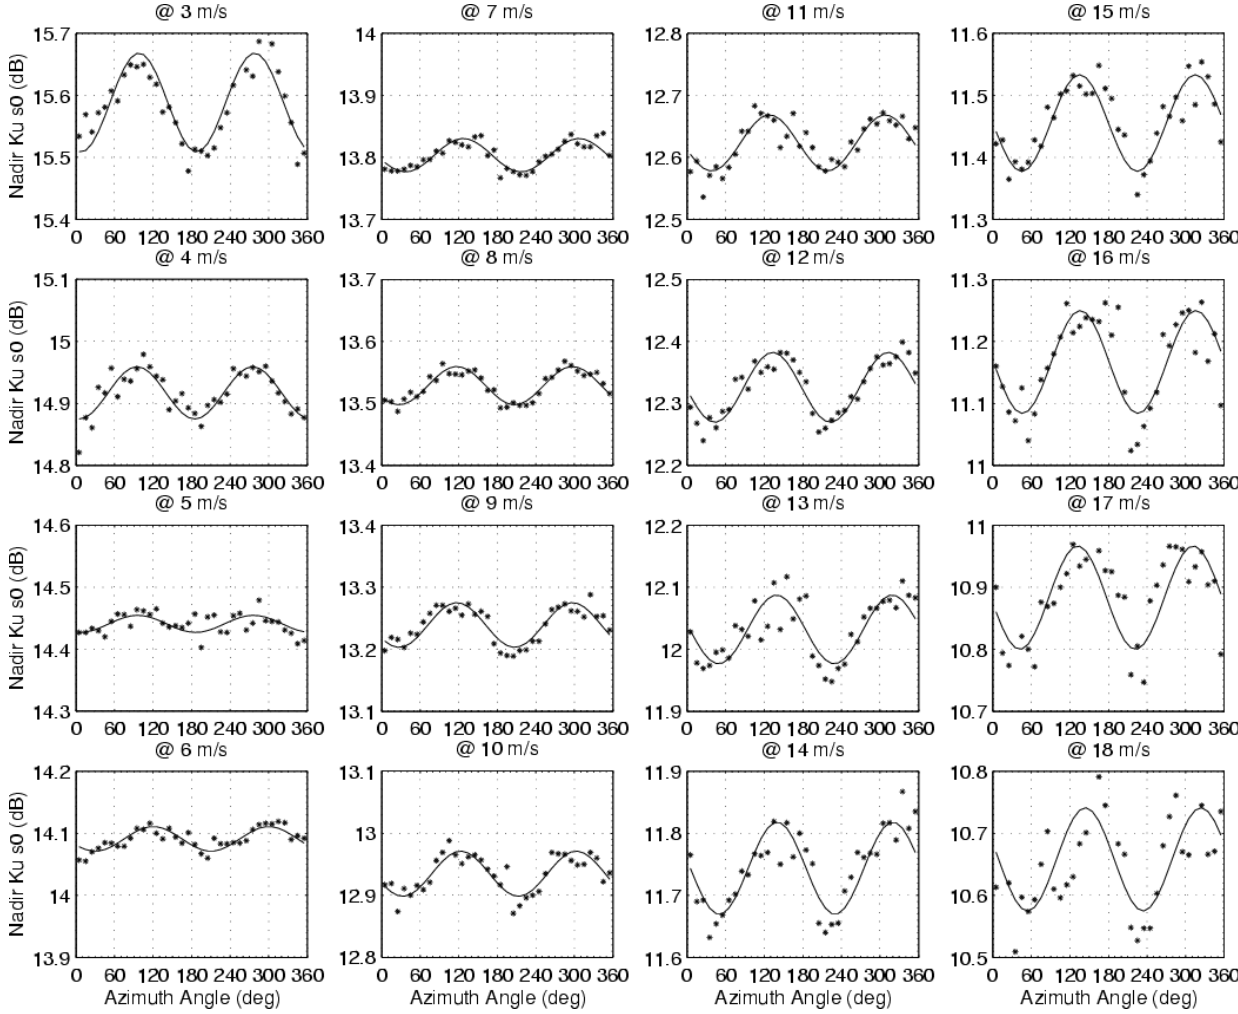
Figure 1. Wind direction signal in 10° bins of the Ku-band altimeter radar cross-section for different wind speeds at ± 0.5 m/s and varying from 3 to 18 m/s. The solid line represents the second-order harmonic fit of form